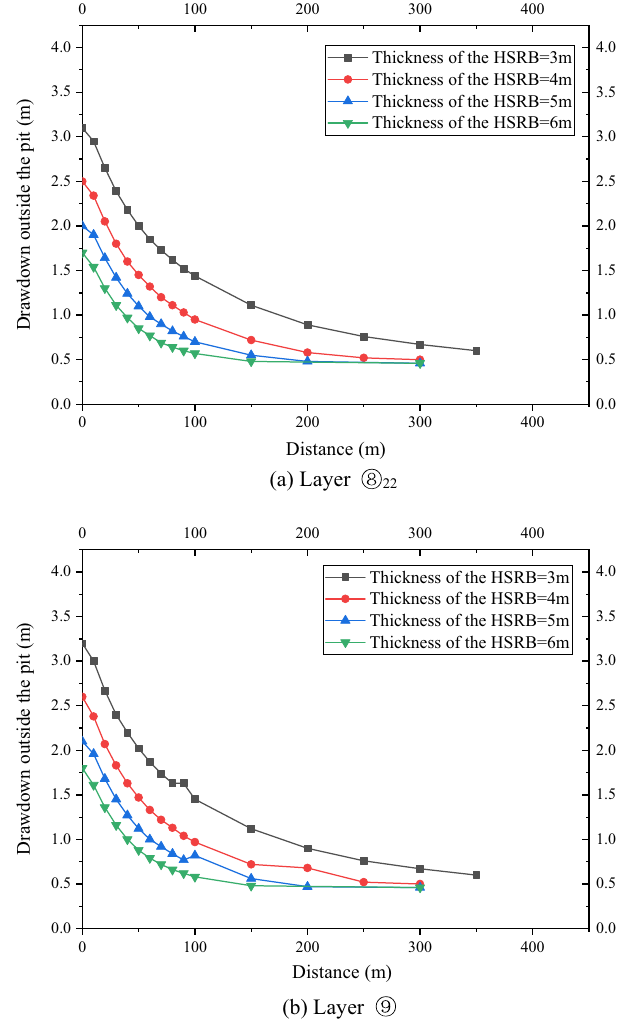
Figure 12. Drawdown–distance curve outside the pit with different HSRB thicknesses.